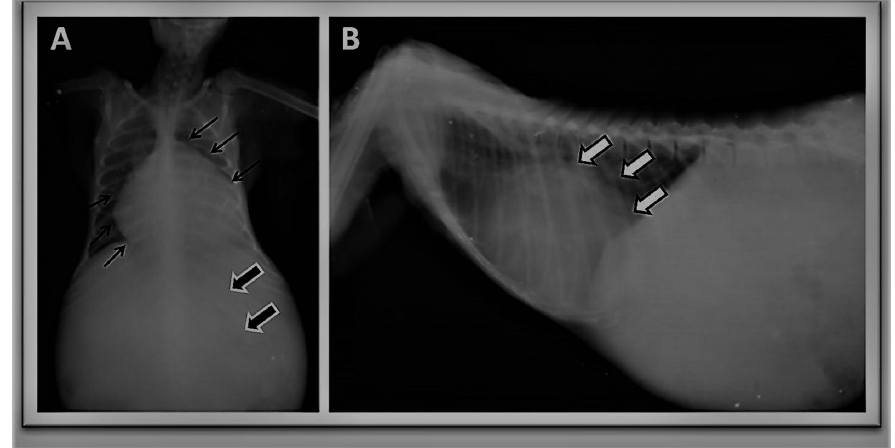
Figure 1. (A) Radiographic examination, in a ventro-dorsal position, evidencing increased cardiac silhouette (fine arrows) and marked abdominal volume (arrow outline); (B) Radiographic examination, in a right lateral position, evidencing an increase in the cardiac silhouette (filled arrow).